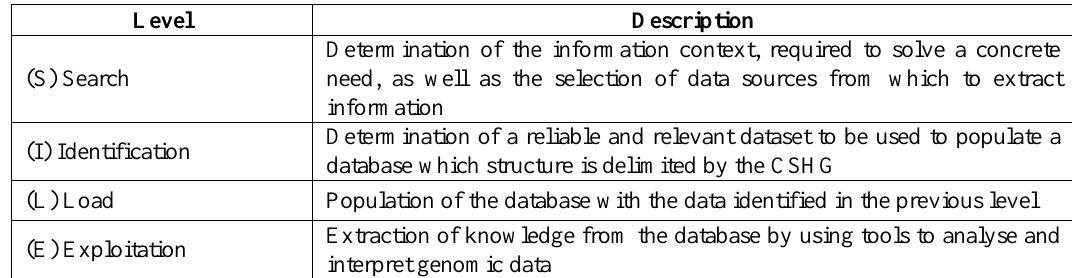
Table 4 . Description of each level of the SILE